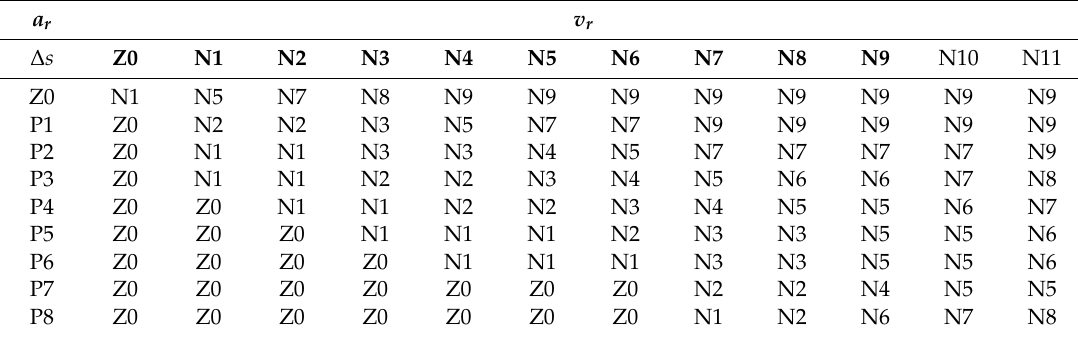
Table 6. The fuzzy control